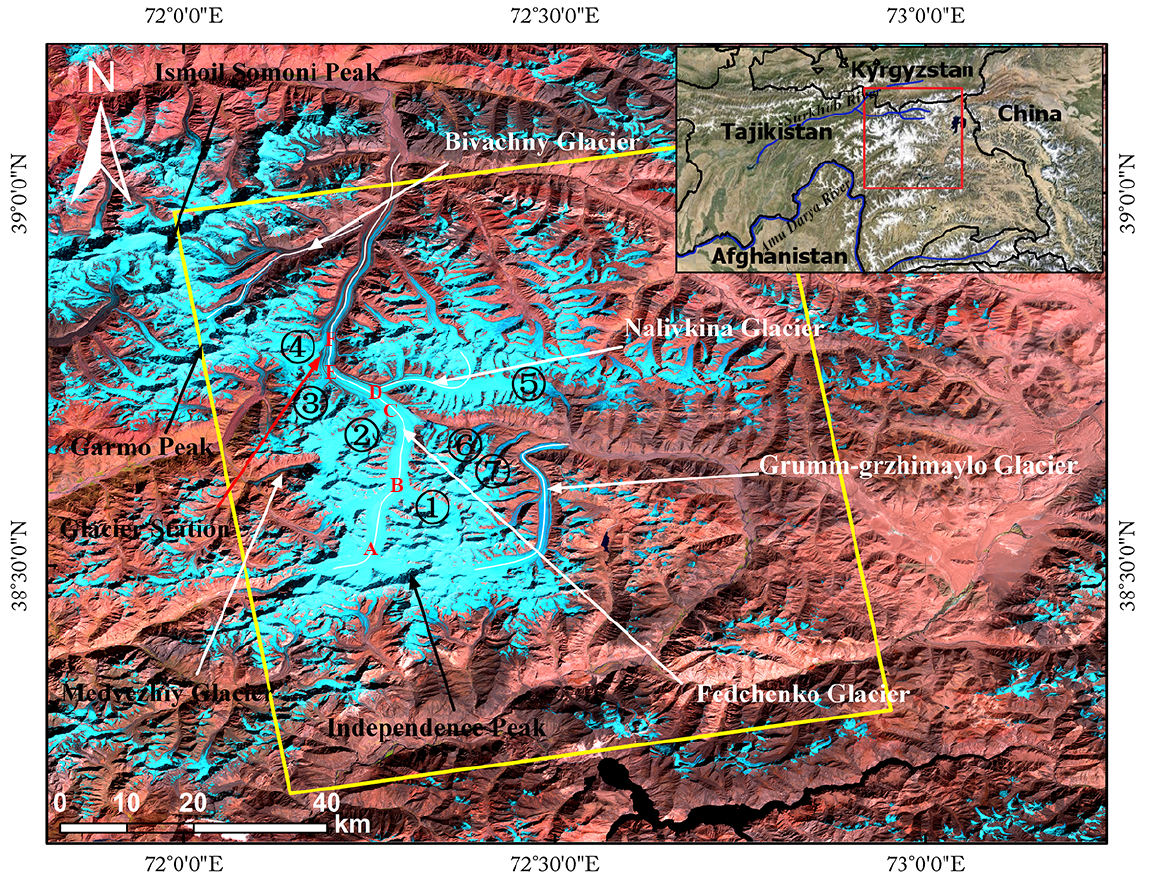
Figure 1. Landsat-7 image of the study area. The cyan represents the mountain glacier distribution. The yellow outline indicates the coverage of SAR imagery. The white profiles are along the center flowlines glaciers. Capital letters A–F show the junction positions. The area of interest is indicated in the inset